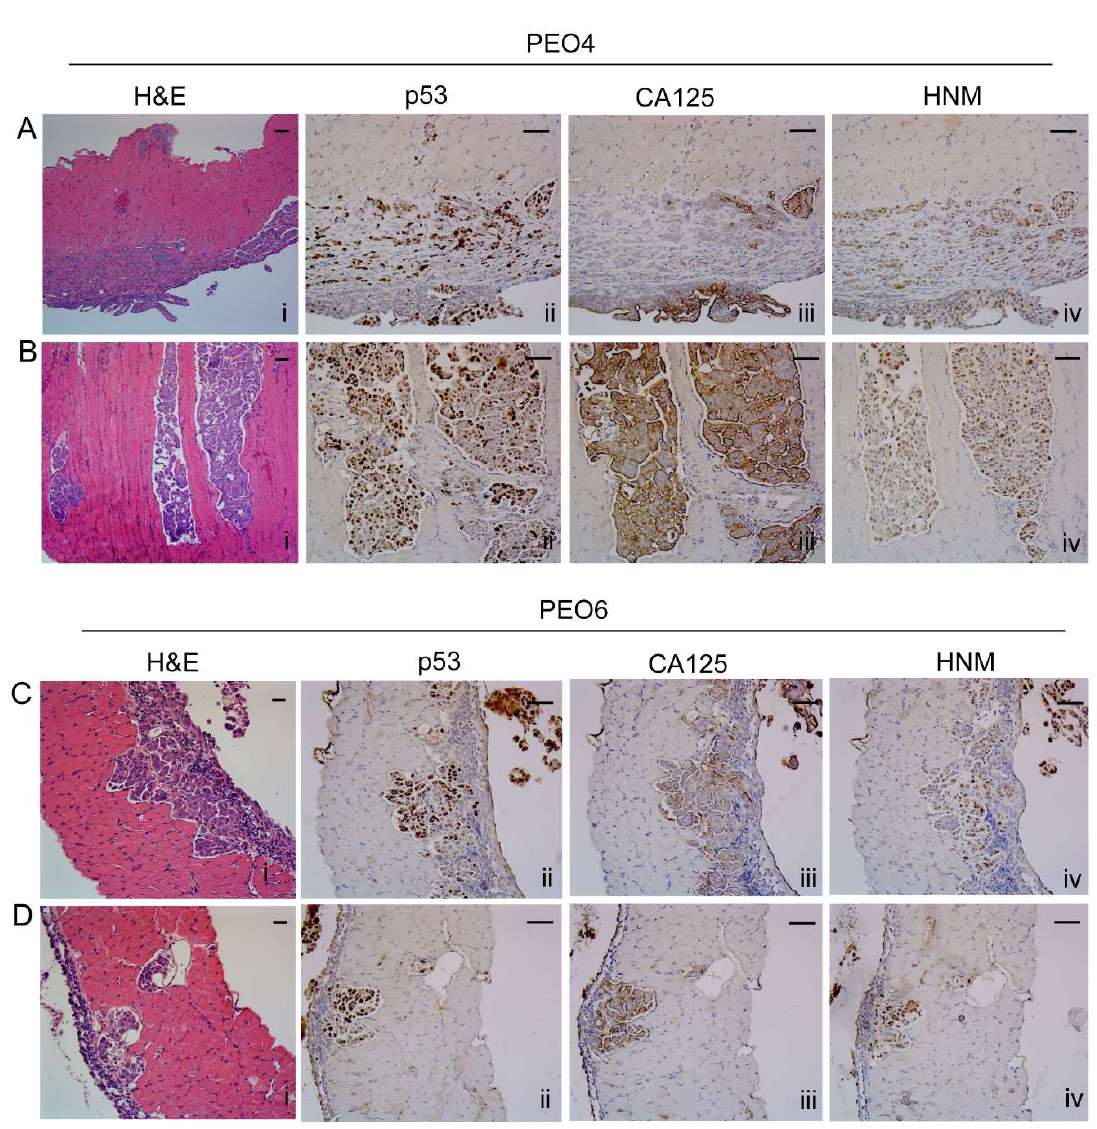
Figure 4. Metastases within the diaphragm. ( A ) Solid pattern of invasion of PEO4 cells visualized by H&E, and expression of p53, CA125, and human nucleoli marker (HNM). ( B ) Micropapillary pattern of invasion. ( C , D ) Different morphological features of metastases by PEO6 cells showing mostly an invasive front with slit-like areas that stain positive for p53, CA125, and HNM. Notice the strongest positivity of the markers in the multicellular structures located around the surface of the diaphragm. Scale bars = 50 μm.